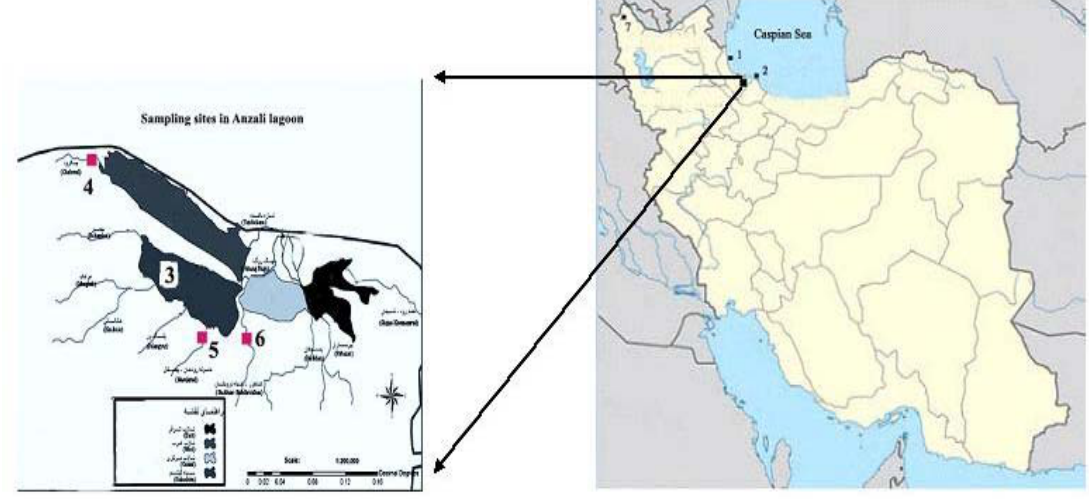
F IGURE 1. Sampling sites of the narrow-clawed crayfish, A. leptodactylus . The localities are labeled with numbers. Detailed information about the sites can be found in Table